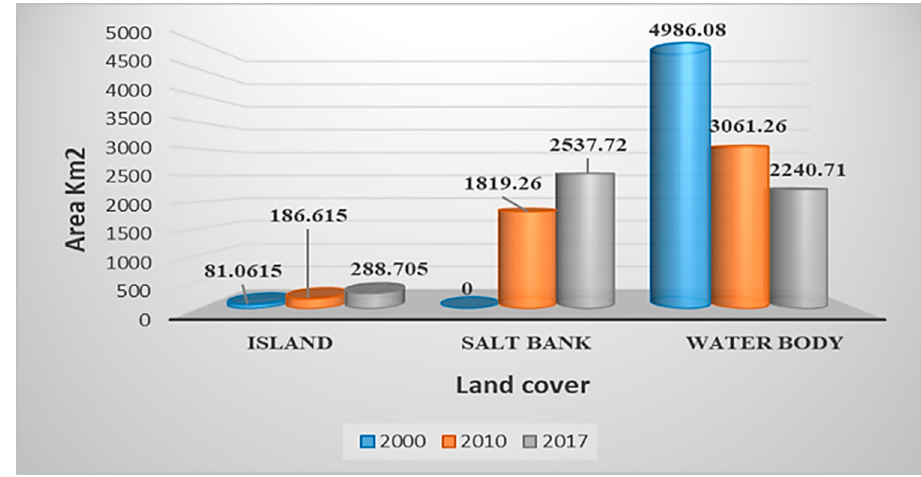
Figure 8. Changes in di ff erent land cover area (km 2 ).